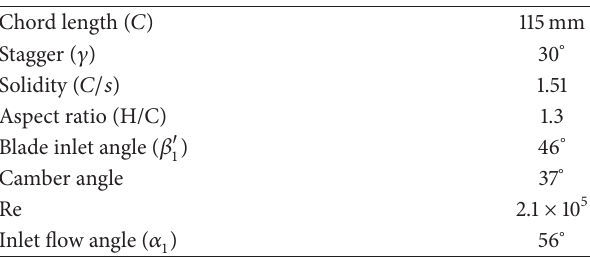
Table 1: Specification of the